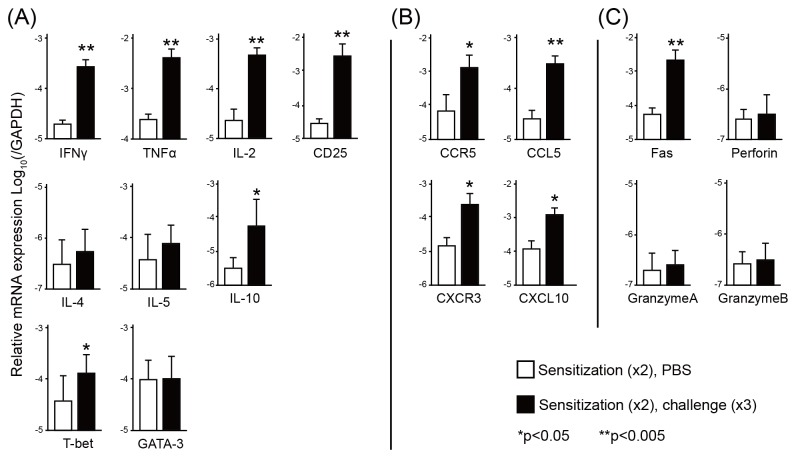
Quantification of T cell related markers and cytokines by qPCR.The mRNA expression of CD25, cytokines (IFN-γ, TNF-α, IL-2, IL-4, IL-5, T-bet, GATA3, and IL-10), chemokines and chemokine receptors (CCR5, CCL5, CXCR3, and CXCL10), and cytotoxic molecules (FasL, perforin, granzyme A and granzyme B) are shown (A-C). RNA was extracted from footpads of Pd-induced allergy mice (two sensitizations/three challenges, closed bars) and control mice (two sensitizations, open bars). GAPDH gene expression was used as an internal control. Vertical bars and error bars indicate the mean values and standard deviation (n=10). Significant differences compared with PBS-injected footpads were analyzed by unpaired Student t-test (*p<0.05, **p<0.005). All experiments were independently performed twice.